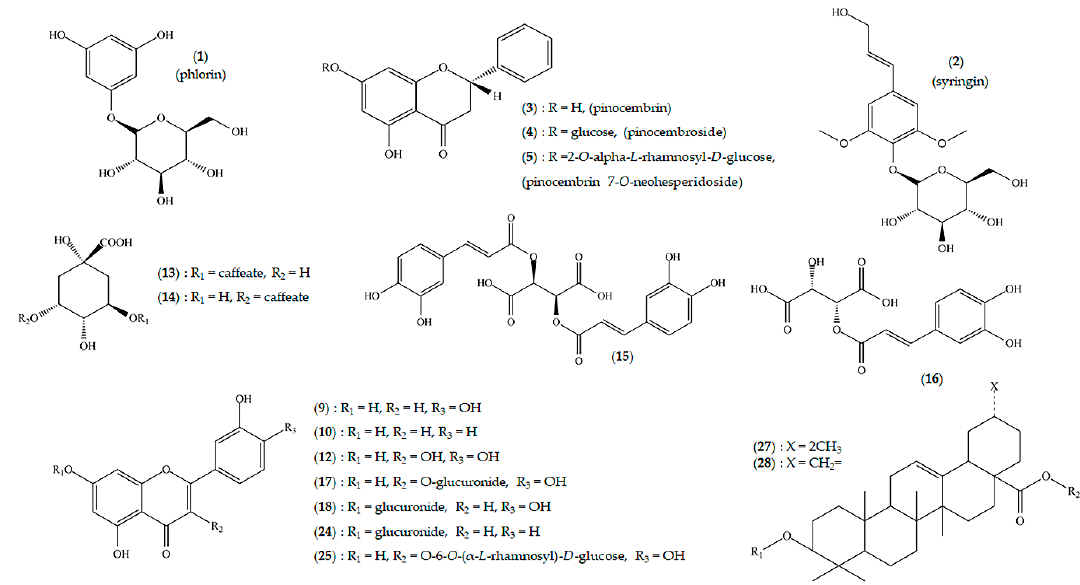
Figure 2. Chemical structures of the main secondary metabolites detected in chórta decoctions.